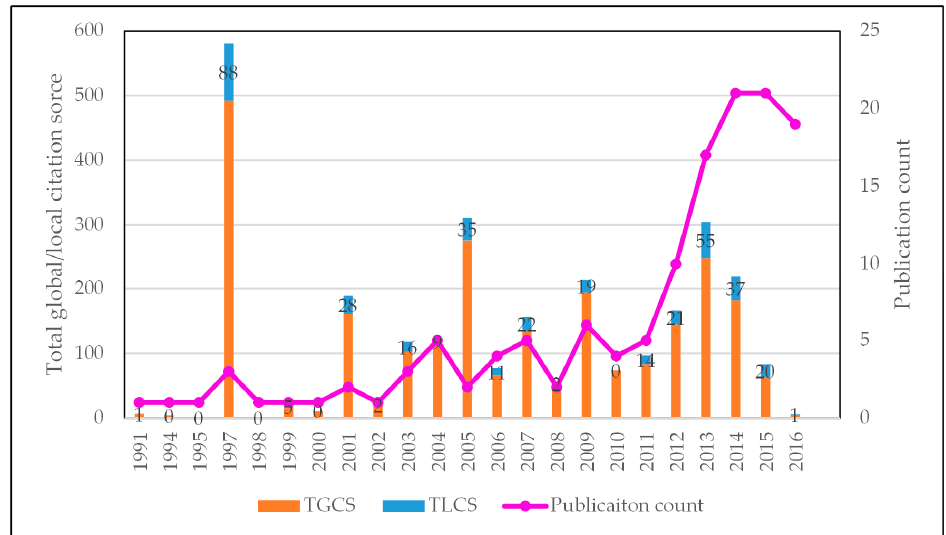
Figure 1. Yearly output of “NTL remote sensing” publication (Note: TGCS stands for total global citation score, TLCS stands for total local citation score, and the Tagged number is the TLCS value).